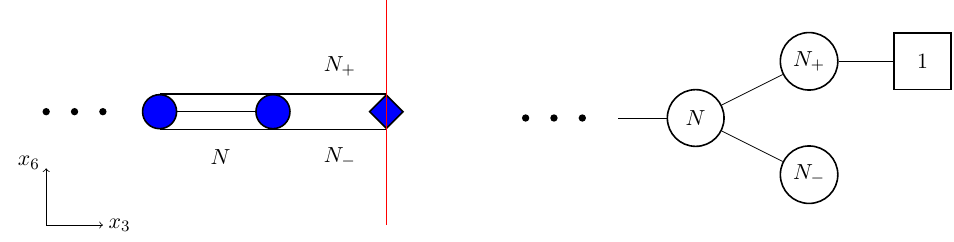
Figure 55 . Type IIB configuration for a bifurcated tail of a D -type quiver with a fractional D5-brane (denoted by a red vertical line) stuck at the orbifold fixed plane. The associated 3d quiver is shown on the